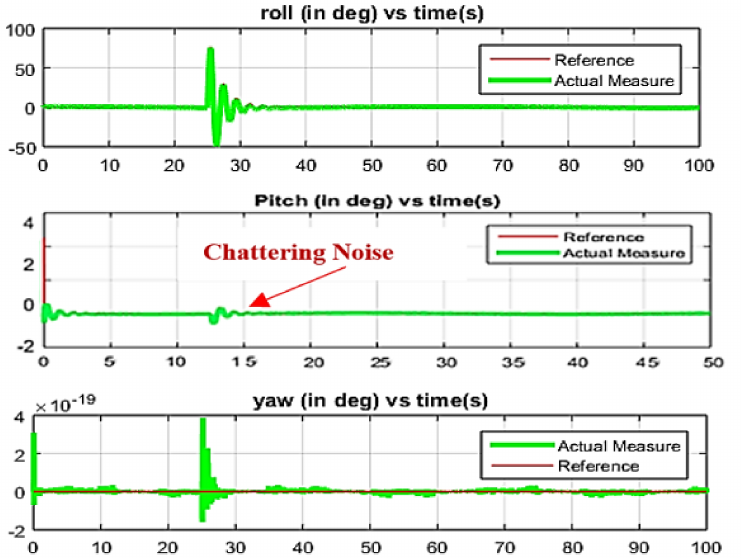
Figure 8. Positional responses using Backstepping control under unmodelled dynamics and external disturbances.